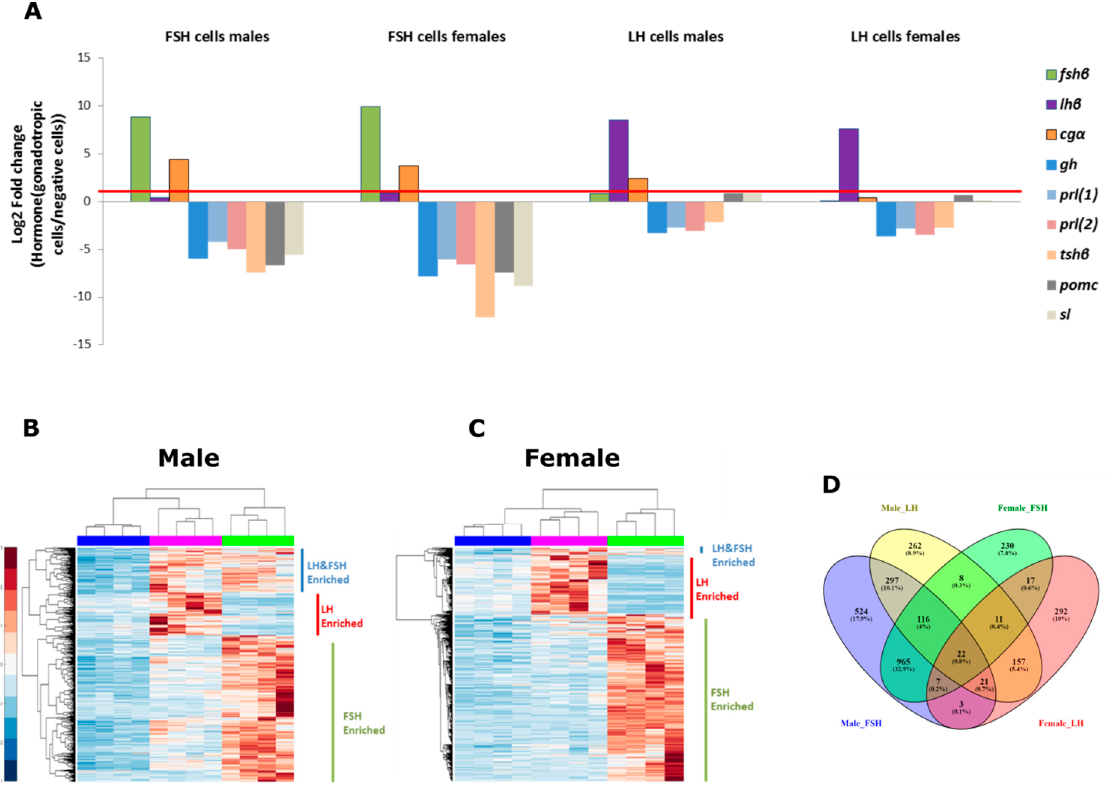
Figure 3. Identifying differentially expressed genes in LH and FSH cells. ( A ) The fold change (represented in log2) of normalized reads of the common pituitary hormone genes in the sorted fractions, as expressed in the RNA-seq libraries. Values are compared to the negative cells fraction. Positive values represent genes enriched in LH and FSH cells and negative values represent genes enriched in the negative cell fraction. Supplementary Table S2 details the exact fold change values for each hormone in each fraction and the gene id for each hormone. As predicted, each hormone (the beta subunits lh β /fsh β together with the common alpha subunit, cg α , which constructs the complete mature hormones) is highly enriched in its own cell type and no other hormone contains a significant expression value in the gonadotrophs. In order to ensure that only LH or FSH cells specific genes are analyzed in each relevant fraction, we filtered for genes with a fold change greater than 2 (log 2 (1), represented by the red line) for the cluster analysis. ( B , C ) Clustergram analysis of normalized reads (FDR corrected p < 0.05, log 2 (Fold change) > 1) in LH, FSH, and negative fractions in each repeat ( n = 4) in males ( B ) and females ( C ). Each repeat from the same fraction was clustered together (top dendrogram). Three main clusters of expressed genes were observed in each clustergram (left dendrogram); genes that were enriched in LH fraction, genes that were enriched in FSH fraction and genes that were enriched in LH and FSH fractions. All the genes used for the clustergram analysis and their values are publicly available in GEO (ID:GSE159470). ( D ) Venn diagram combining the male and female clustergram results, representing the number of enriched genes in each cluster and in each sex revealing high number of genes that are either cell specific or sex specific and only 22 genes that are common to all. The diagram was created using Venny_2.1 (https://bioinfogp.cnb.csic.es/tools/venny/) (accessed on 24 September 2019).